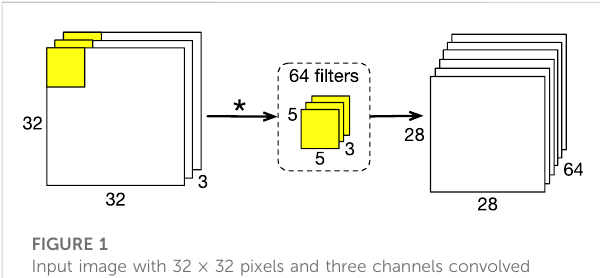
FIGURE 1 Input image with 32 × 32 pixels and three channels convolved with64 fi ltersofsize5×3×3,endingupin5×5×3×32×32×64=4, 915, 200 multiplication operations. The input channels are convolved with each fi lter separately and further